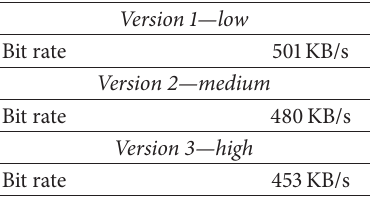
Table 2: The bit rate of VPN